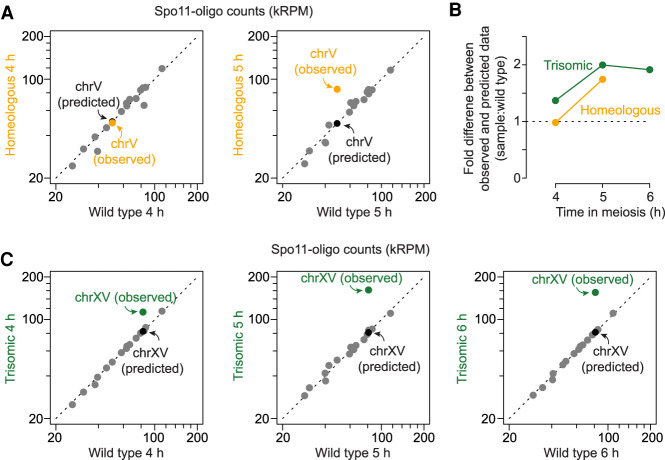
Increased DSBs are observed specifically on homeologous chrV and trisomic chrXV. (A,C) Comparison of per-chromosome Spo11-oligo totals (kRPM [thousands of reads per million reads mapped]) between homeologous and wild type in A (4 h [left]; 5 h [right]), and between trisomic and wild type in C (4 h [left]; 5 h [middle]; 6 h [right]). Each dot represents one chromosome. A predicted data point assuming that the homeologous chrV or trisomic chrXV has the same number of reads as the homologous chrV or chrXV is shown in each graph. The deviation of two chromosomes (chrIX and chrXII) from the diagonal line in A, left, are likely due to a small difference in timing between the two cultures; these chromosomes are known to experience DSB formation relatively late on average (Murakami et al. 2020). (B) The fold difference between experimental and predicted values for the karyotypically abnormal strains (from A and C) at different meiotic times. Dashed line marks no change, meaning the experimental data matches prediction.